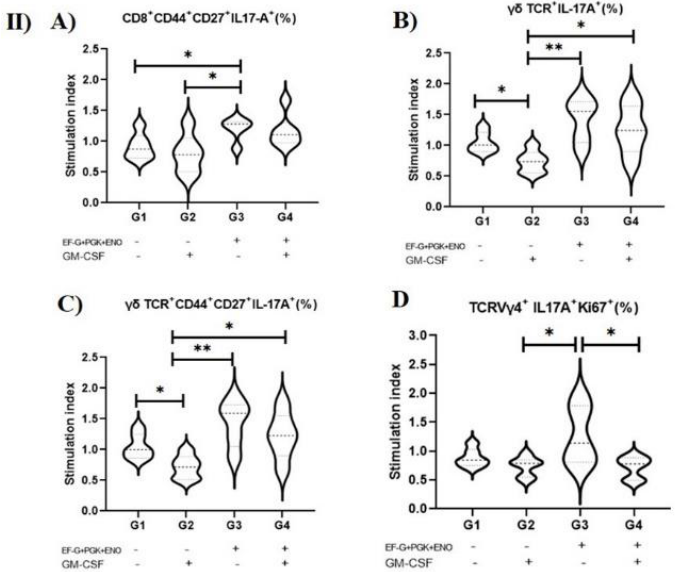
Figure 2. Percentage of IL-17A + T cells in mice vaccinated with three S. aureus -cure-associated recombinant proteins. T cell responses are normalized by dividing the percentage of IL-17A + cells upon S. aureus stimulation per the percentage of IL-17A + cells under unstimulated control a stimulation index. ( I ) Representative gating of IL-17A production by different lymphocyte populations. ( II ) Stimulation index of ( A ) T CD8 + CD44 + CD27 + (central memory) cells, ( B ) overall γδ TCR + cells, ( C ) γδ TCR + CD44 + CD27 + (central memory) cells, and ( D ) TCRV γ 4 + Ki67 + cells. Granulocyte-macrophage colony-stimulating factor; EF-G: elongation factor-G, ENO: enolase; and PGK: phosphoglycerate kinase. * indicate p ≤ 0.05, ** indicate p ≤ 0.01. (One-way ANOVA followed by Tukey test).